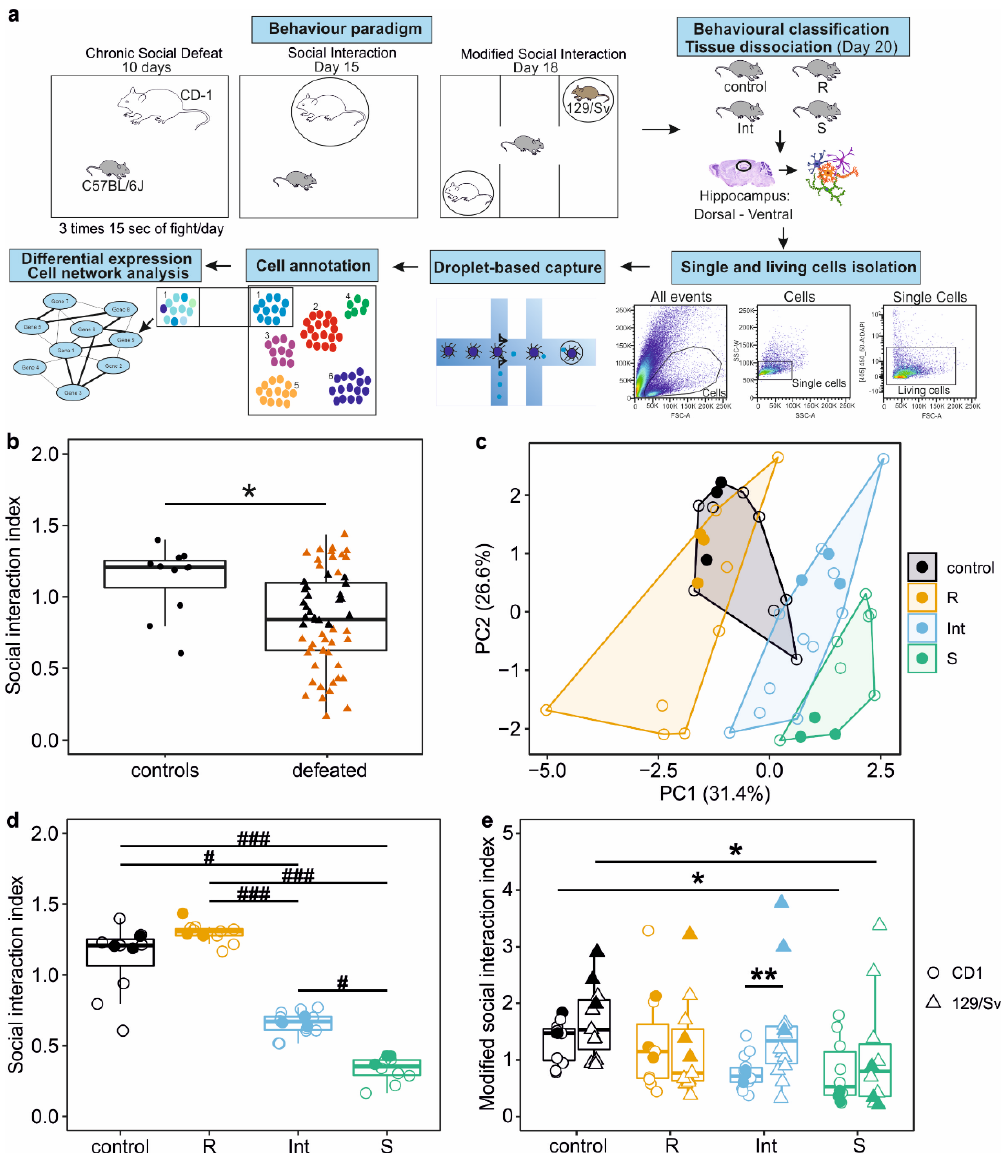
Figure 1. Behavioural classification of mice after chronic social defeat stress. ( a ) Overview of the experiments. Chronic social defeat stress was applied for 10 days with 3 times 15 s of fight per day. After 4 days, behavioural profiling was started. After the behavioural classification, three mice per stressed group (R, Int, S) and three non-stressed mice were selected. Brains were collected 2 days after the last behavioural test, and the dorsal and ventral hippocampus were dissected. Tissues were dissociated, and single and living cells were isolated by using a fluorescence-activated cell sorter. A total of 32,000 single-cells were captured by a droplet-based method and sequenced. Different cell populations were identified, the differentially expressed genes between the groups were analysed, and cell networks were uncovered. ( b ) Social interaction (SI) index of controls and defeated mice. After CSDS, two subgroups of defeated mice (highlighted in brown), i.e., the socially avoiding (SI < 0.75) and the socially non-avoiding (SI > 1.15) mice, were further subjected to a modified social in- teraction (MSI) test. ( c ) Based on their SI scores, the selected defeated mice highlighted in Figure 1b were clustered into three sub-phenotypes. Behavioural groups are visualized with principal com- ponent analysis, with four groups termed control (black), resilient (orange, R), intermediate (blue, Int), and susceptible (green, S) mice. The area around each cluster corresponds to the convex hull. ( d ) SI index of the four groups of mice. ( e ) SI index in the MSI test of the four groups of mice. Filled circles and triangles in ( c – e ): individual mouse taken for subsequent single-cell RNA-seq experi- ment. * p < 0.05, ** p < 0.01 (Wilcoxon test in b, linear mixed-effects model followed by Tukey com- parisons of marginal means in ( e ), # p < 0.05, ### p < 0.001 (Kruskal–Wallis test followed by Dunn’s posthoc comparisons in ( d) ).